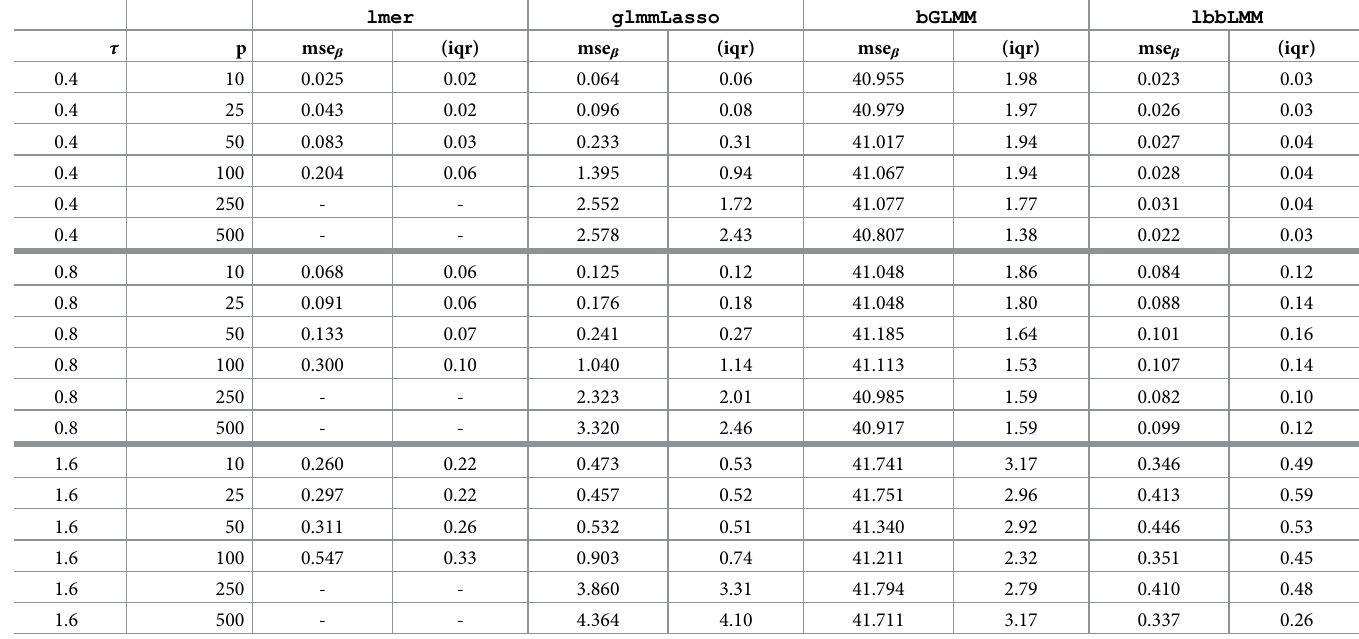
Table 4. Median mse β of 100 independent simulation runs for each random slopes setup with corresponding interquartile range. lmer glmmLasso